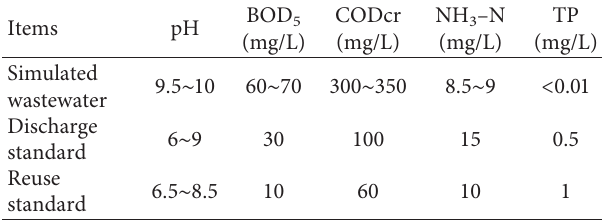
Table 1: The water quality of simulated flotation wastewater and standard concentration limits.